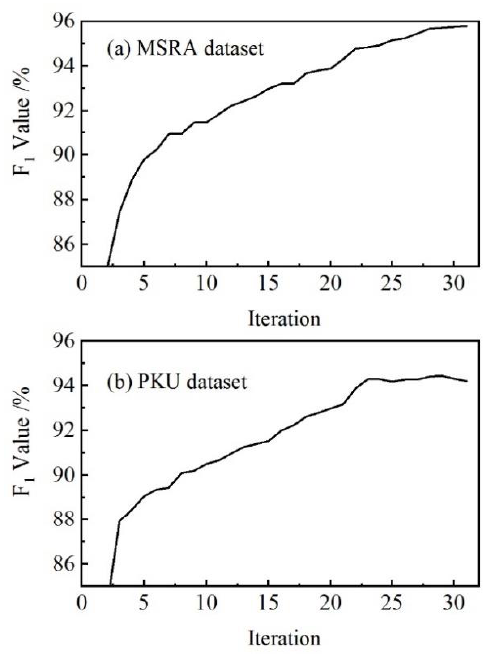
Figure 6. F 1 values of the Chinese segmentation model.